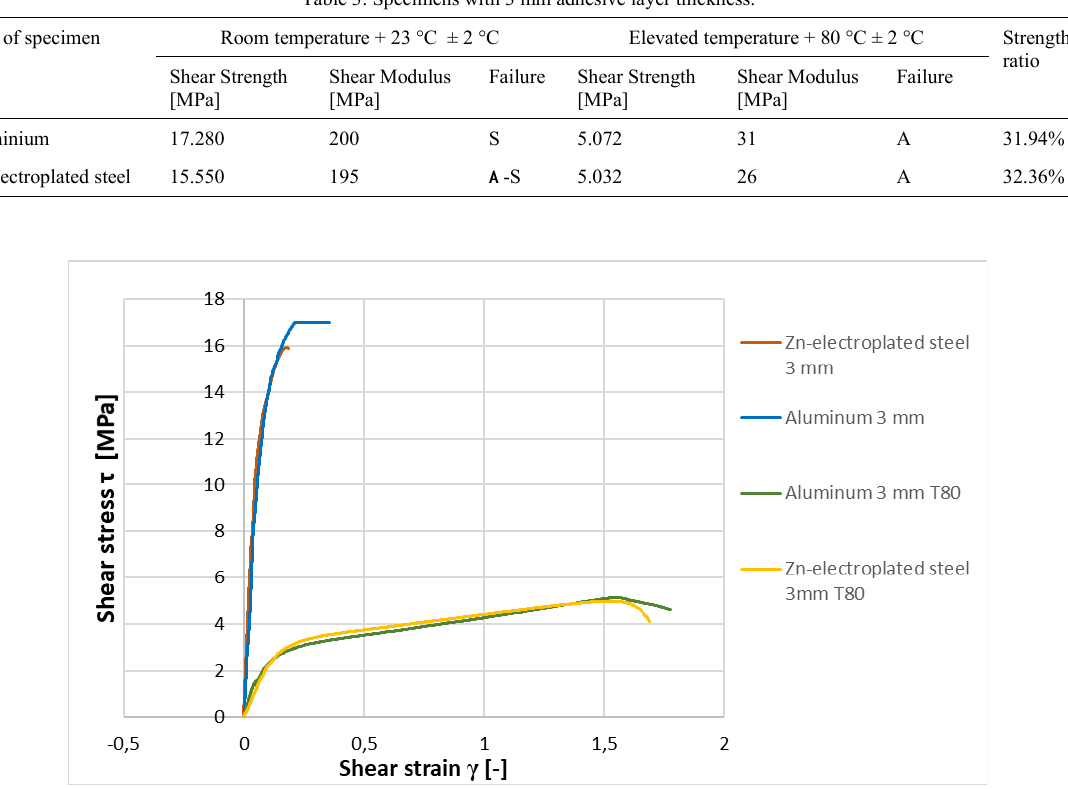
Fig. 7 Stress-strain relationship for specimens at room and elevated